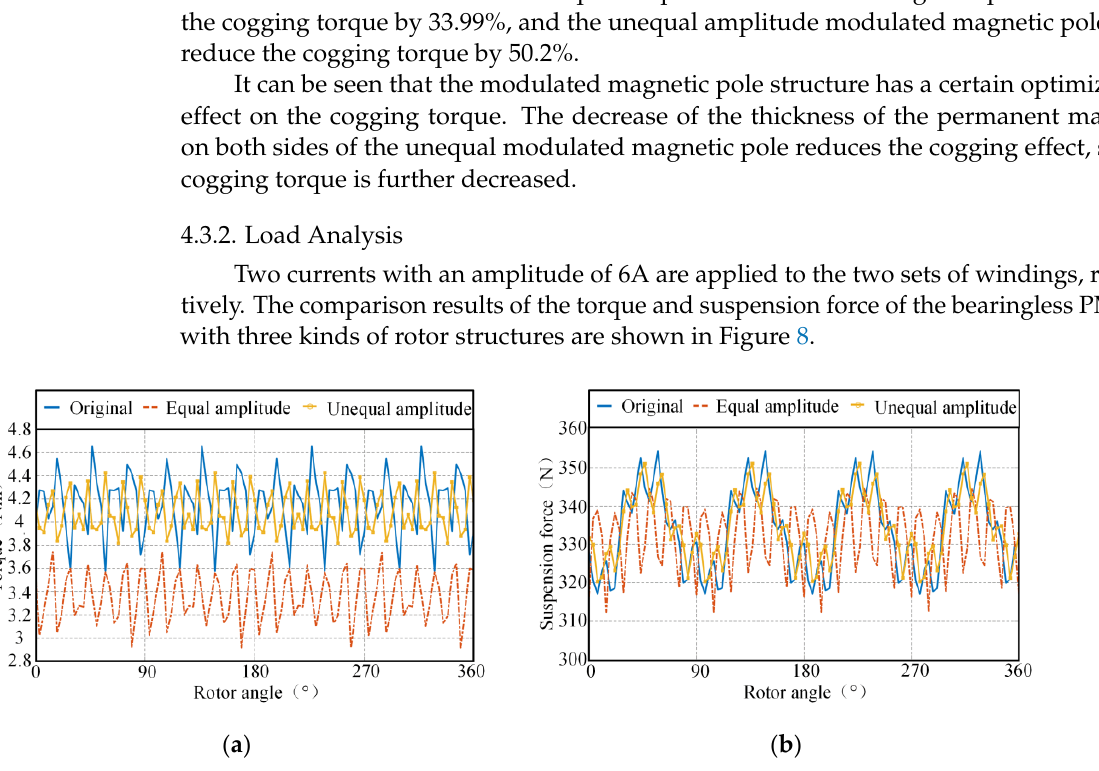
Figure 7. Comparison Results of Cogging Torque.